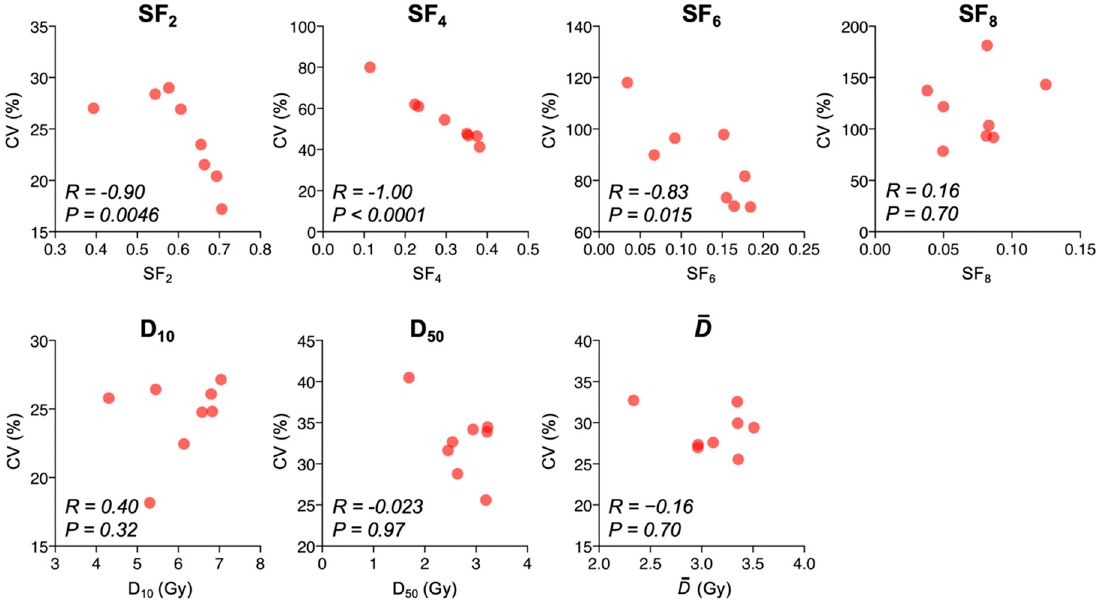
Figure 4. Correlation between CV values and corresponding clonogenic survival endpoints. R values and p values (assessed by Spearman’s rank correlation test) are shown.